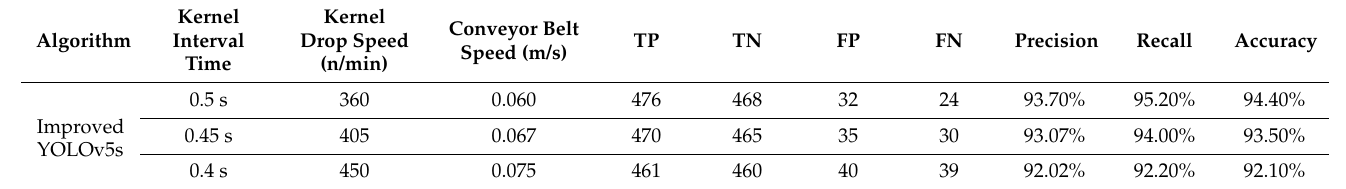
Table 6. Results of the real-time sorting experiment.